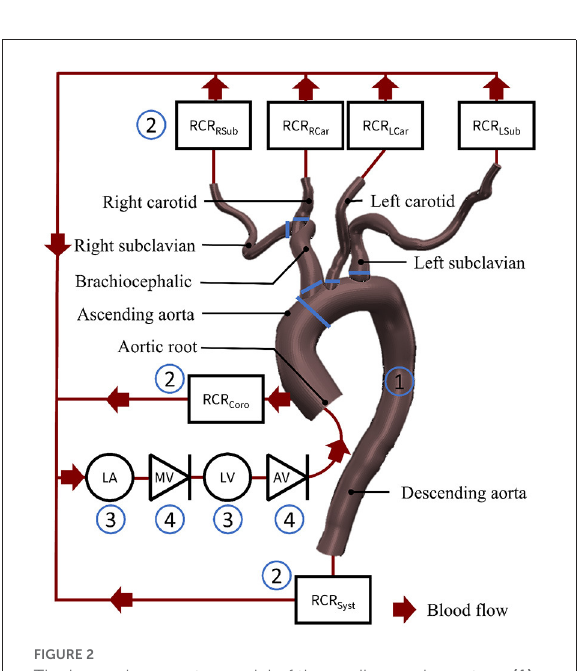
FIGURE2 The lumped parameter model of the cardiovascular system, (1) is the aorta, (2) are the peripheral circulation elements, (3) are the chamber elements, (4) are the valve elements. LA, left atrium; MV, mitral valve; LV, left ventricle; AV, aortic valve; RCRRSub, resistance capacitance resistance element at the right subclavian artery; RCRRCar, resistance capacitance resistance element at the right carotid artery; RCRLCar, resistance capacitance resistance element at the left carotid artery; RCRLSub, resistance capacitance resistance element at the left subclavian artery; RCRCoro, resistance capacitance resistance element at the coronary arteries; RCRSyst, resistance capacitance resistance element of the systemic circulation.